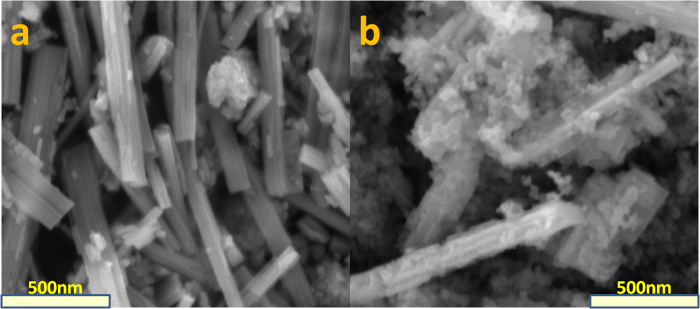
SEM image of (a) (NH4)xWO3 (b) P/4NWO.